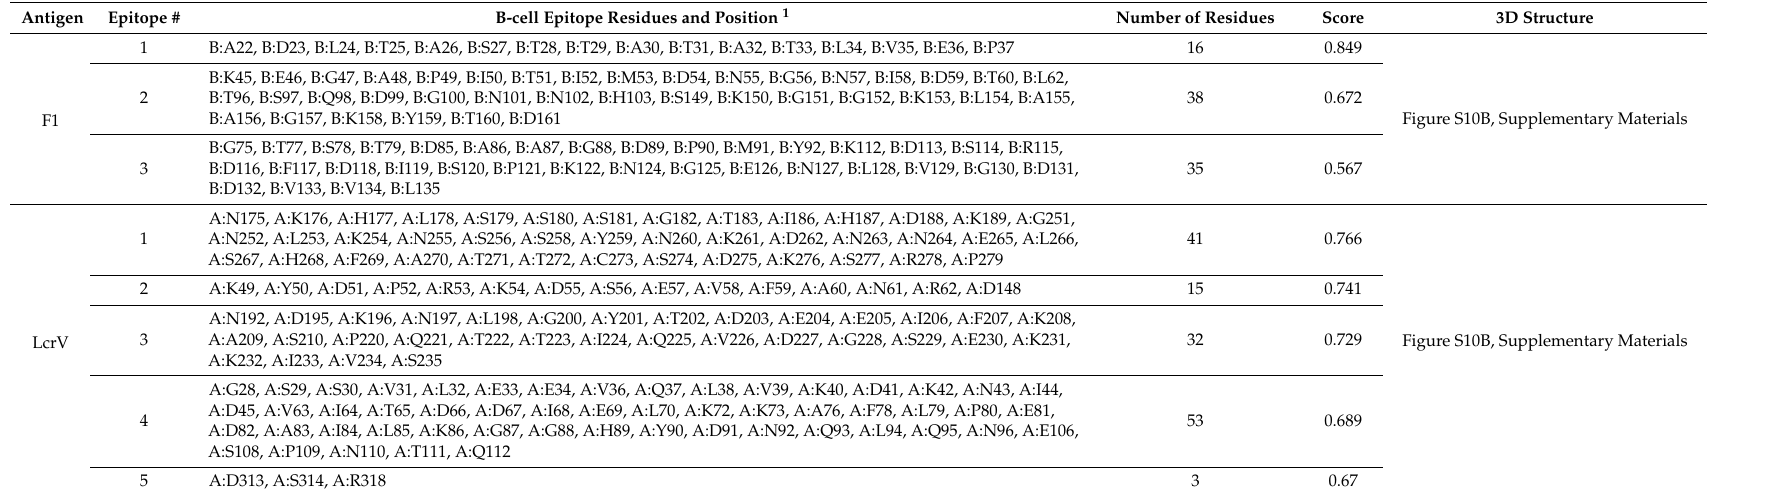
Table 2. Conformational B-cell epitopes of F1 and LcrV predicted in